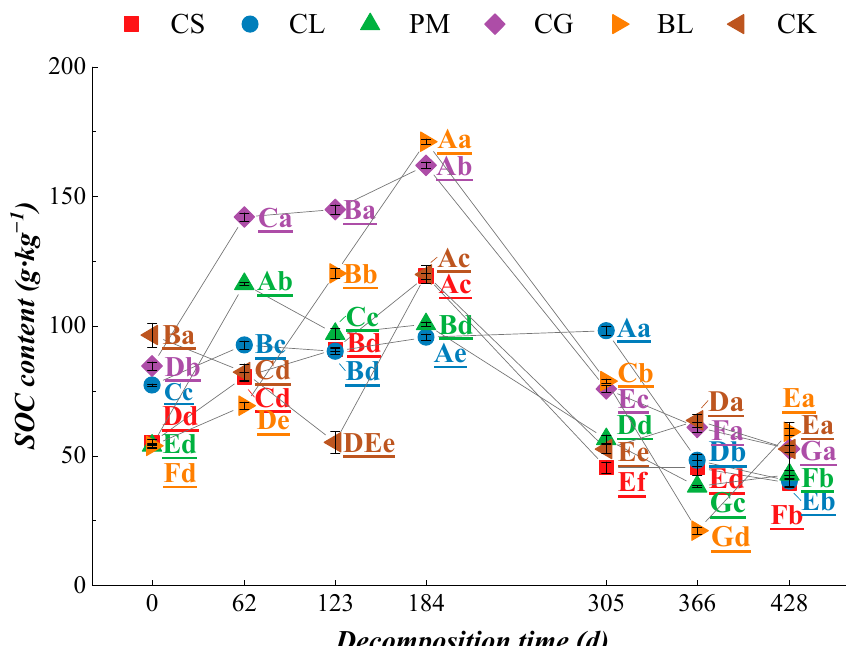
Figure 6. Dynamic changes in SOC content in different litter decomposition processes. CS— Camellia sinensis , CL— Cunninghamia lanceolata , PM— Pinus massoniana , CG— Cinnamomum glanduliferum , BL— Betula luminifera , CK—control; SOC—soil organic carbon; A, B, C—differences between decom- position stages of the same treatment; a, b, c—differences between treatments in the same decom- position period.